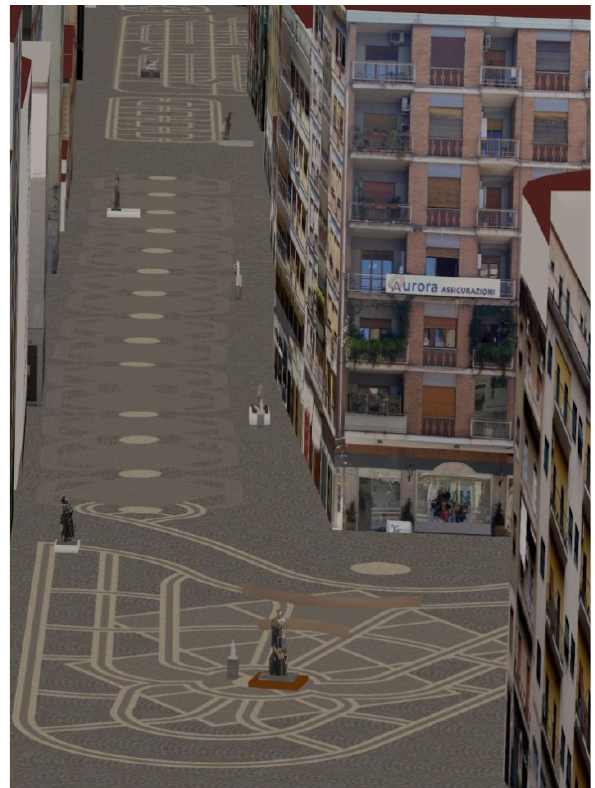
Figure 18. North view of the city model with the new arrangement of statues.